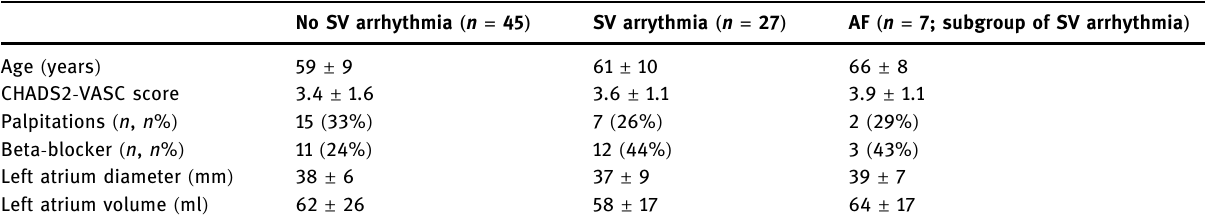
Numerical data are presented as mean ± SD. No signi fi cant di ff erences between groups were observed. SV, supraventricular; AF, atrial fi